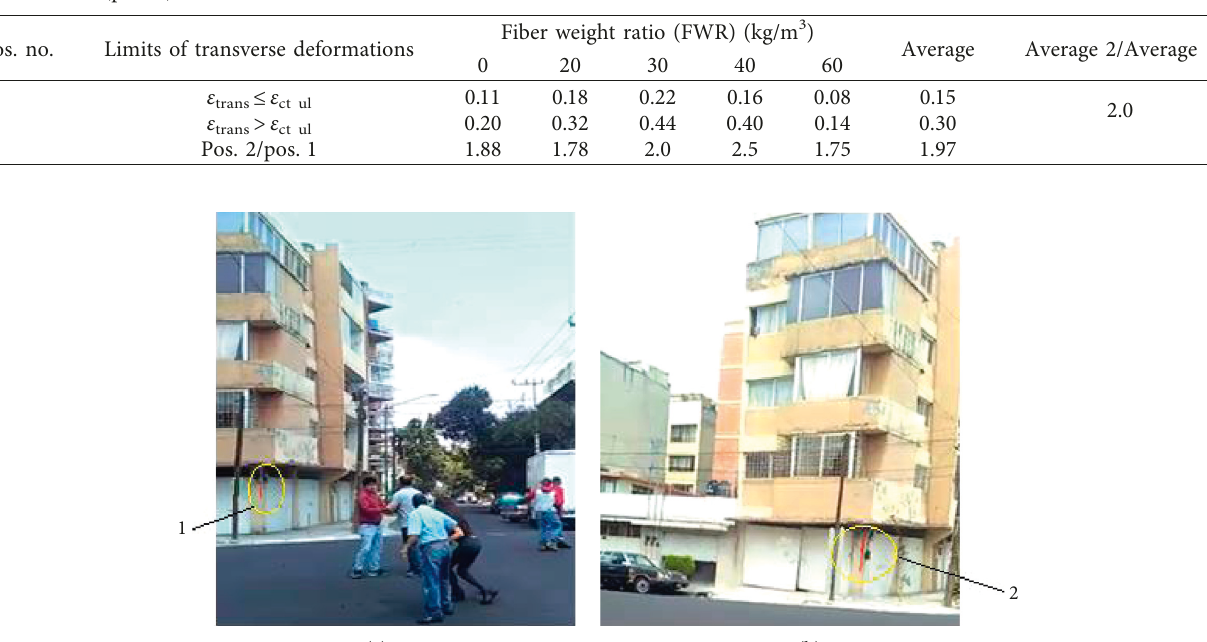
Figure 3: Transverse cracks in a column during Mexico earthquake 2017 [25]: (a) 2 sec. (b) 15 sec. 1: crack initiation; 2: crack